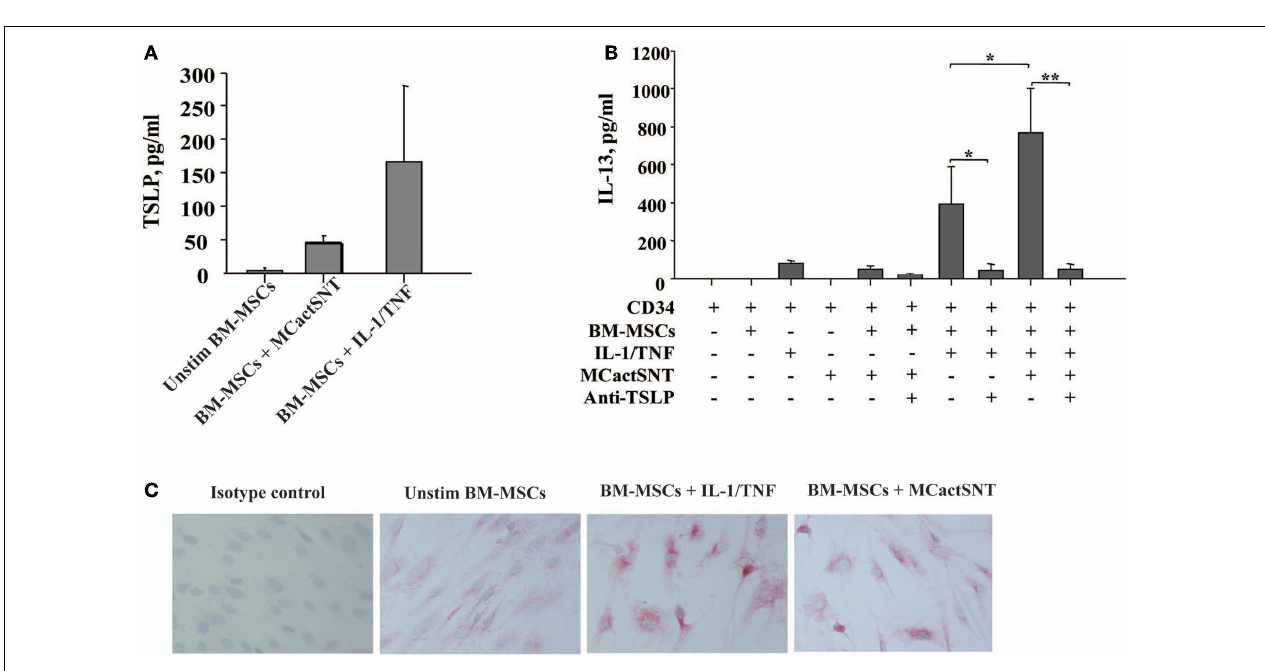
supernatants, suboptimal concentrations of IL-1/TNF (1ng/ml of each), and neutralizing antibody toTSLP (10 µ g/ml), as indicated and supernatants were assessed for IL-13 release. Control isotype antibody had no activity. Mean ± SEM of eight experiments. (C) Representative staining of mesenchymal stromal cells cultured under conditions indicated with anti-TSLP polyclonal